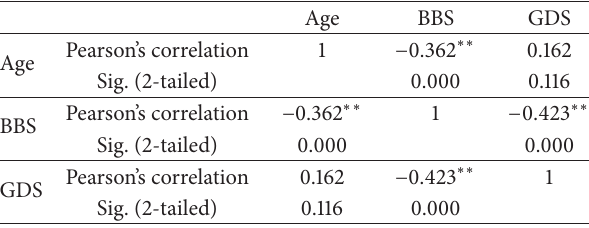
Figure 3: Scatter plot between Berg Balance Scale (BBS) and Geriatric Depression Scale (GDS) scores. Table 2: Correlation between age, BBS, and GDS.